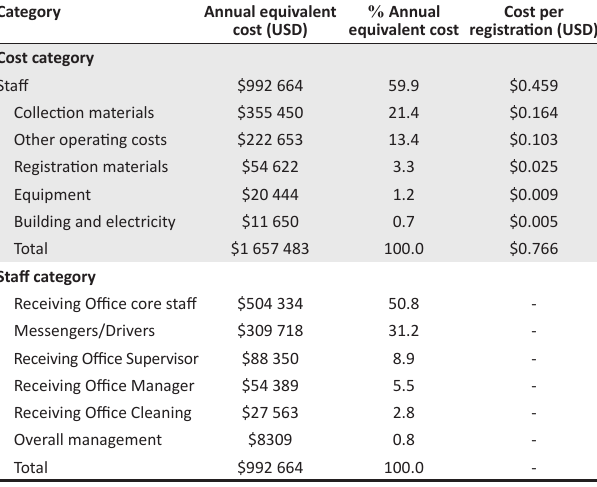
TABLE 2: Annual equivalent costs and the cost per registration for each cost category at the Charlotte Maxeke Johannesburg Academic Hospital